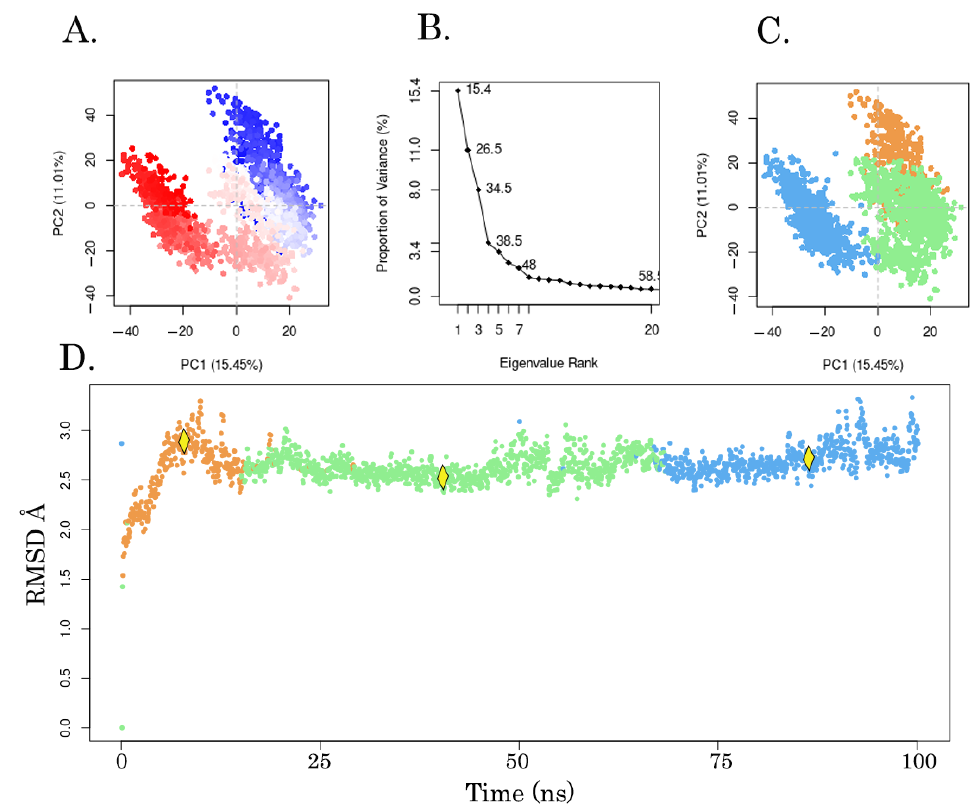
Figure 10. Principal component analysis (PCA) of EAPC-67-tubulin complex trajectory. ( A ) Plotting PC1 component ( x -axis) versus PC2 component ( y -axis). Each dot denotes the one conformation of the protein. The spread of blue and red color dots describes the degree of conformational changes in the simulation, where the color scale from blue to white to red is equivalent to the simulation time. The blue indicates the initial timestep, white is intermediate and the final timestep is represented by the red color. ( B ) The proportion of variance per each principal component. ( C ) Clustering of the EAPC-67-tubulin complex conformations in the PC1-PC3 subspace based on the K-means method and projection of cluster members onto the PC1-PC2 plot diagram. A member of each of the three clusters is indicated by a separate color. ( D ) Conformational clusters of the EAPC-67-tubulin complex are displayed on the RMSD plot. Each dot represents a complex conformer, and the yellow markers indicate the representative conformations (medoids–snapshots 834, 1556, and 1987) of each cluster.